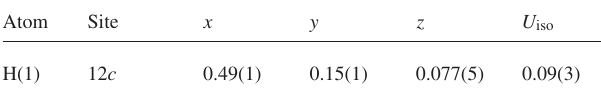
Table 2. Atomic coordinates and displacement parameters (in Å 2 )